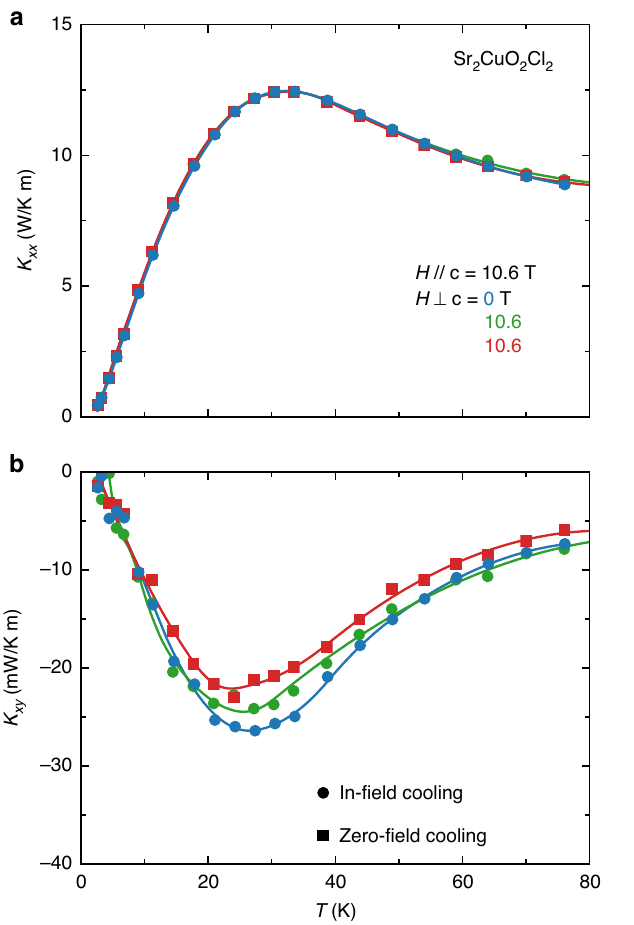
Fig. 5 Effect of magnetostructural domains in Sr 2 CuO 2 Cl 2 . Thermal